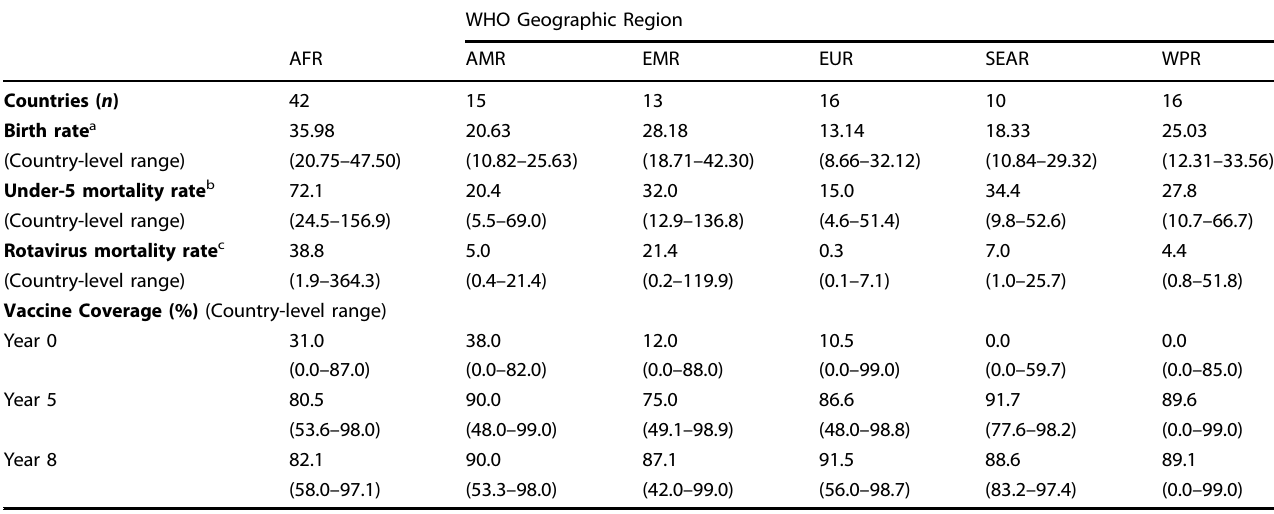
Table 5. Median birth rate, under-5 mortality rate, rotavirus mortality rate, and vaccine coverage of countries grouped by WHO geographic